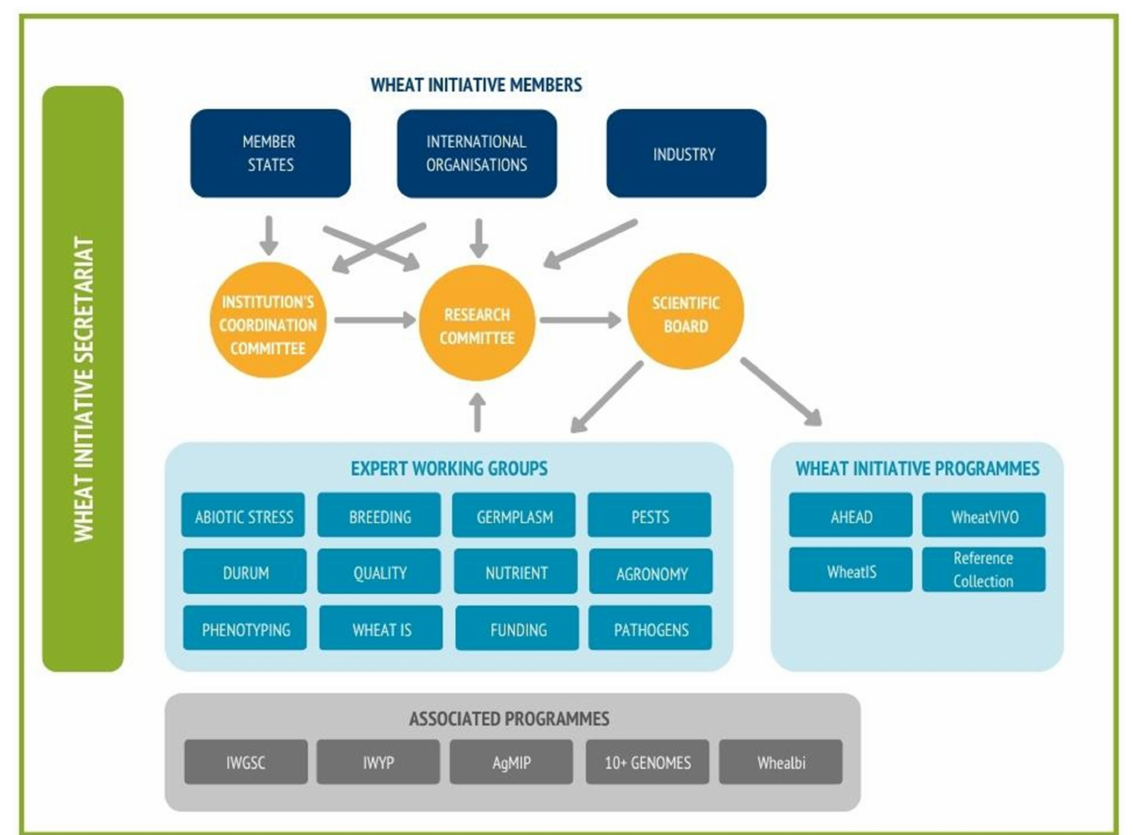
Figure 1. Wheat Initiative organisational